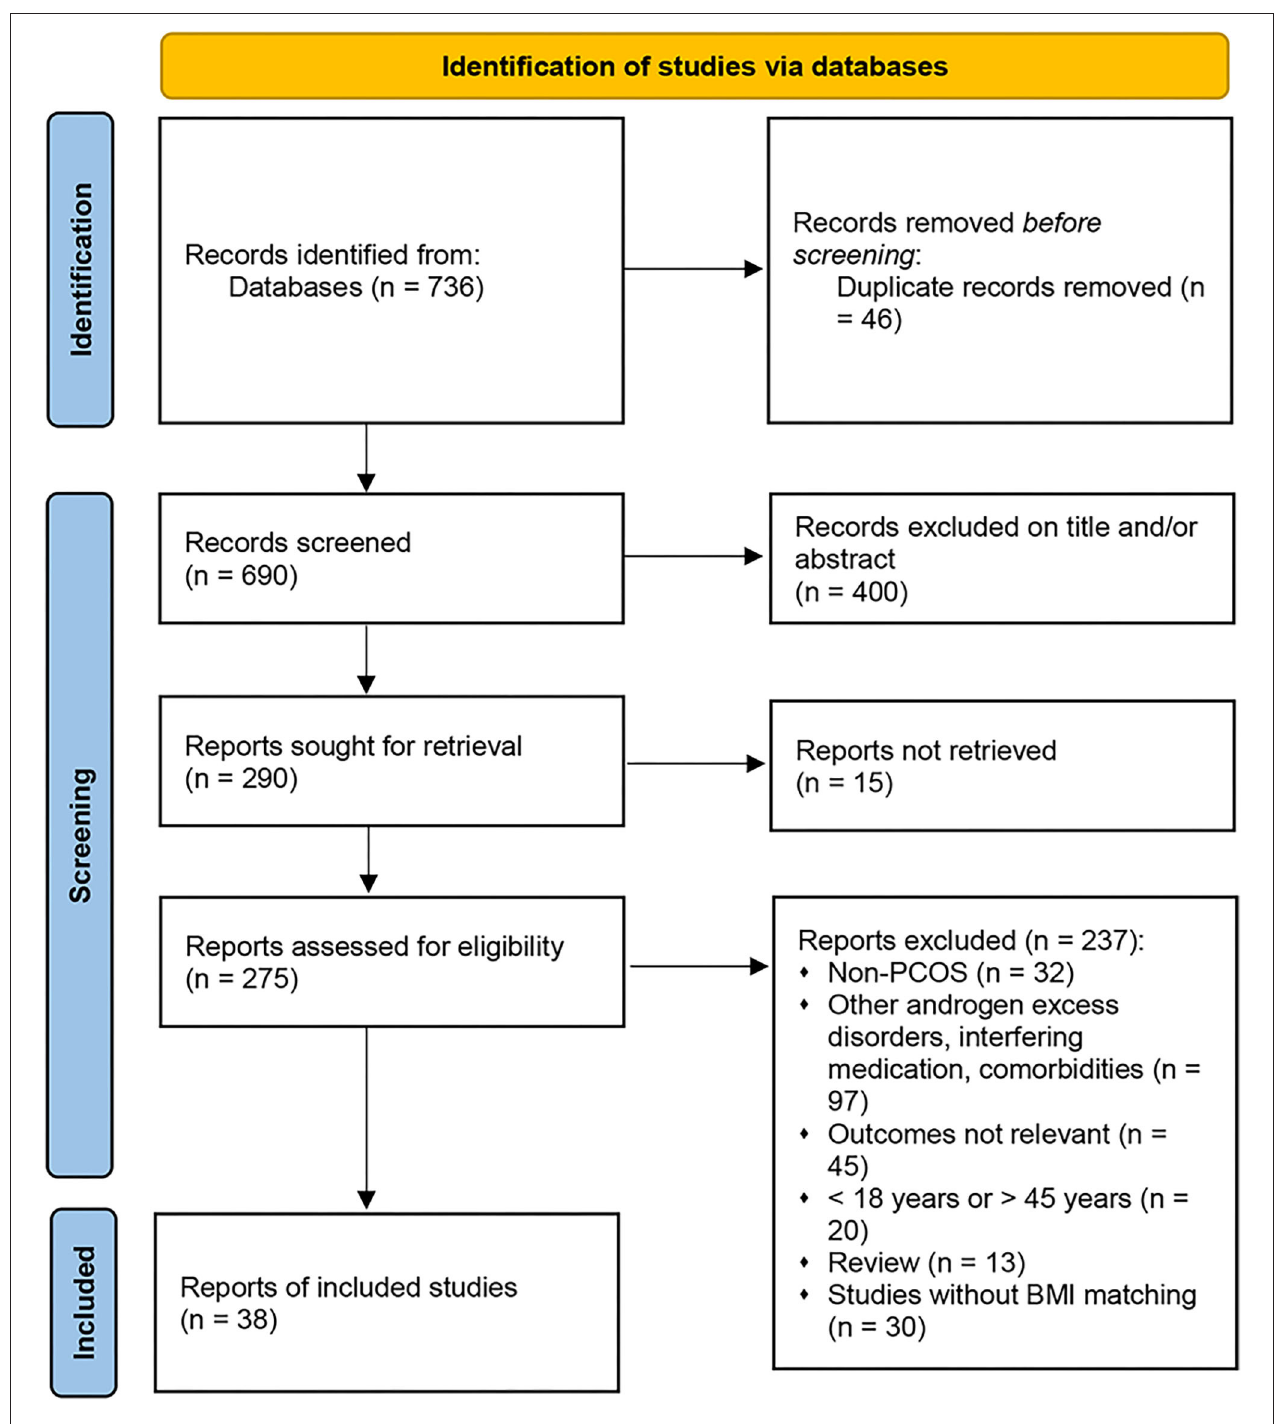
FIGURE 1 | PRISMA flow chart of the study selection procedure.